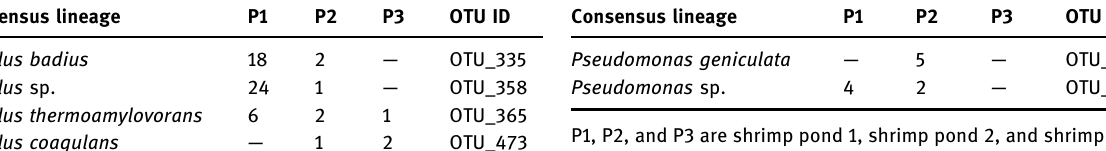
Table 4: Bacterial species identi fi ed from the GI tracts of white shrimps reared in commercial shrimp ponds Consensus lineage